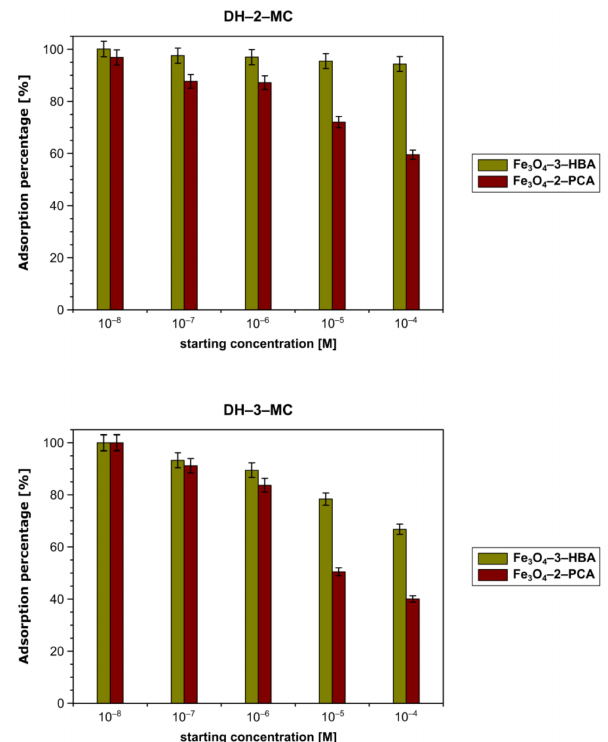
Figure 5. The percentages of ( top ) DH-2-MC and ( bottom ) DH-3-MC adsorption by two Schiff base-functionalized magnetic hybrid materials.